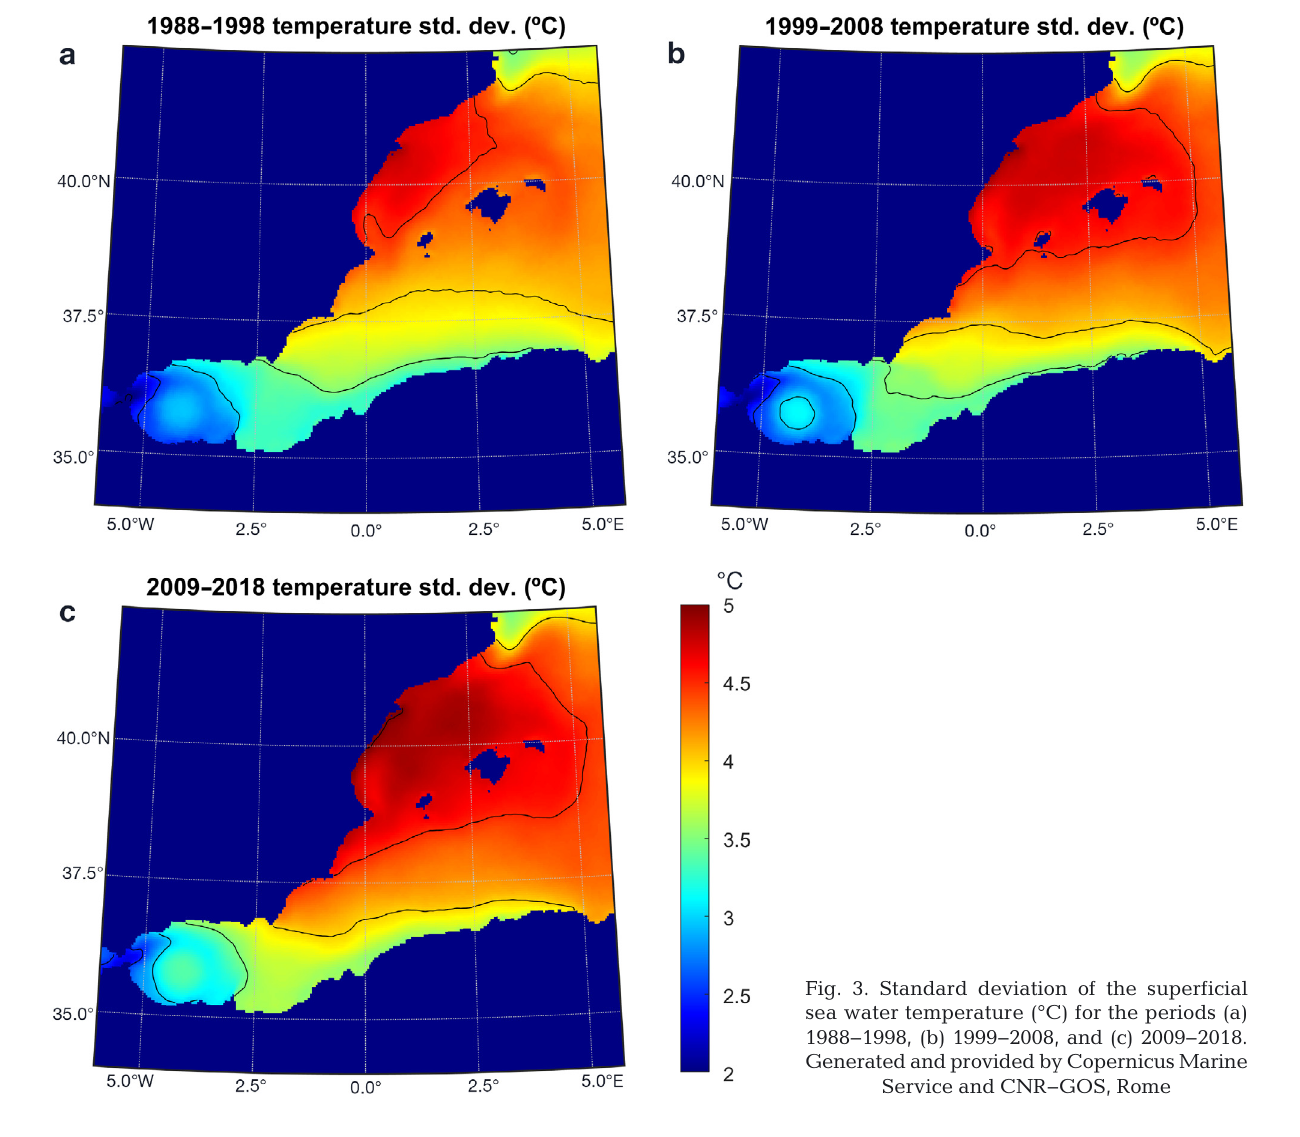
Fig. 3. Standard deviation of the superficial sea water temperature (°C) for the periods (a) 1988− 1998, (b) 1999−2008, and (c) 2009−2018. Generated and provided by Copernicus Marine Service and CNR−GOS,